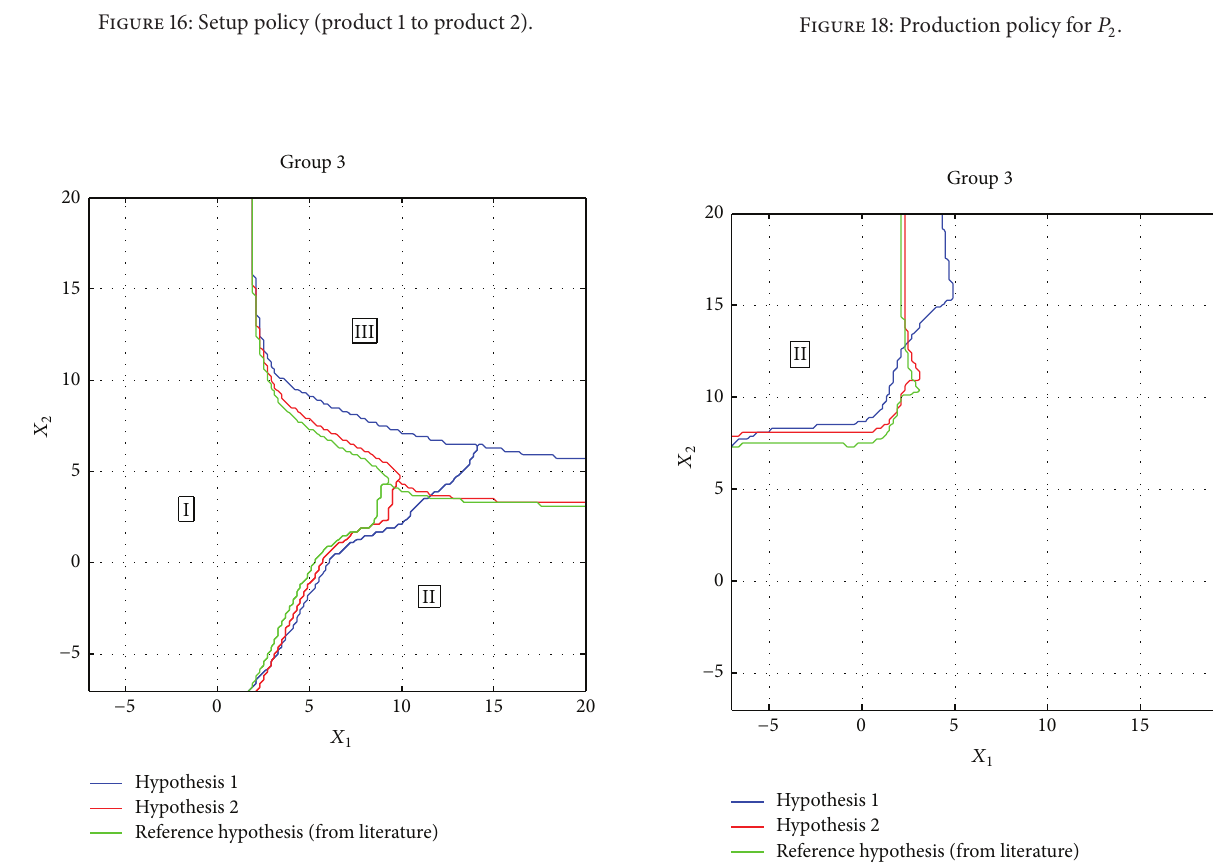
Figure 18: Production policy for 𝑃 2 .